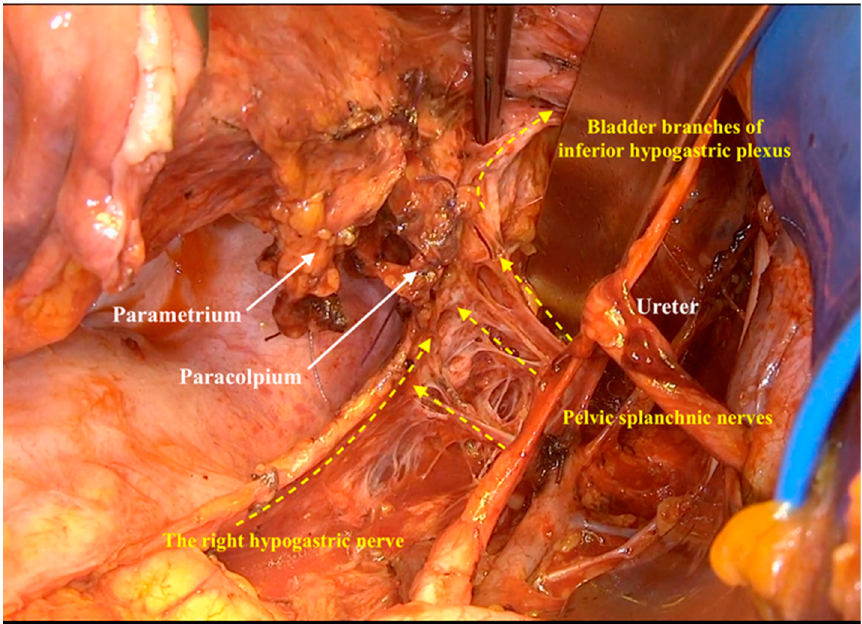
Figure 8. Highlighting all the components of inferior hypogastric plexus after resecting the ventral paracolpium.